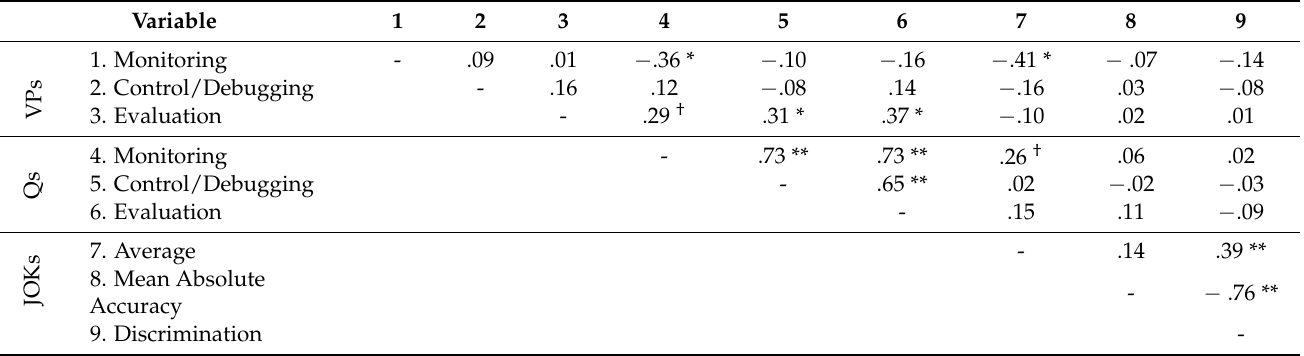
Table 5. Correlations between the task-based questionnaire, verbal protocols, and judgments of knowing.